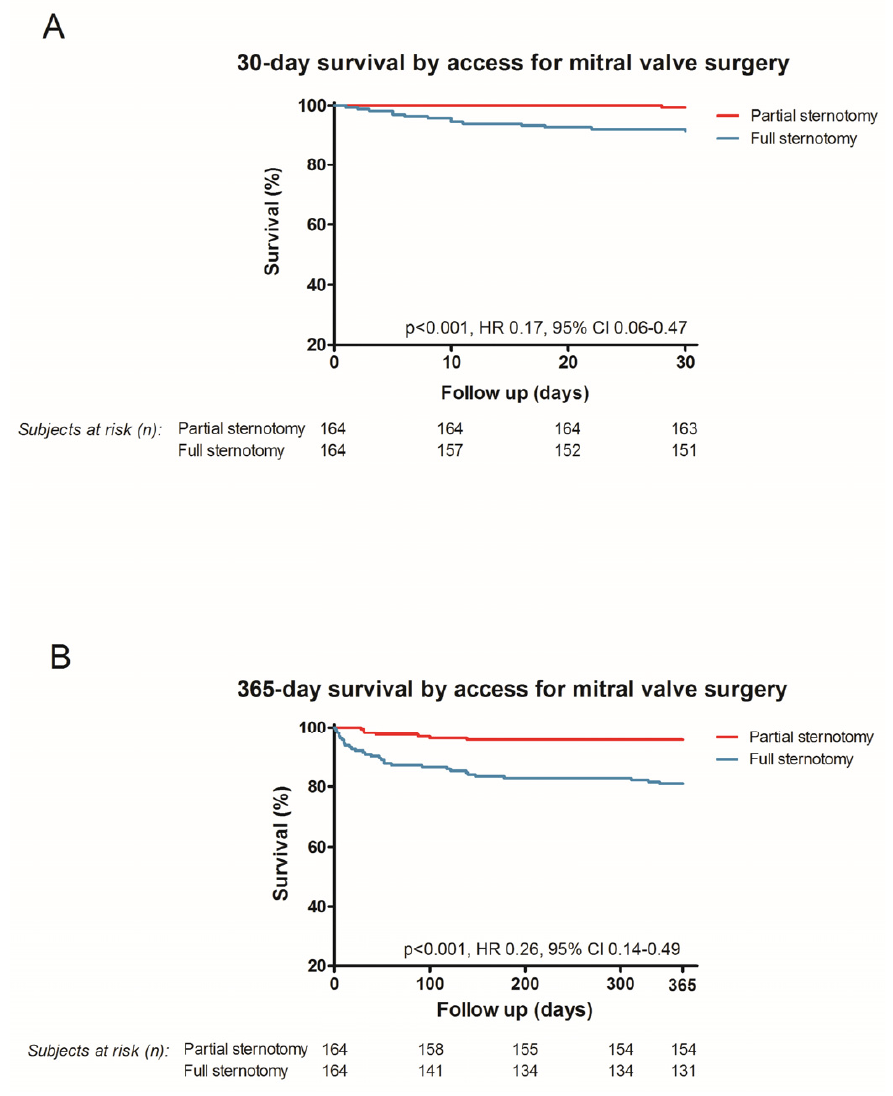
Figure 2. Kaplan–Meier curves for 30 days ( A ) and one year ( B ).